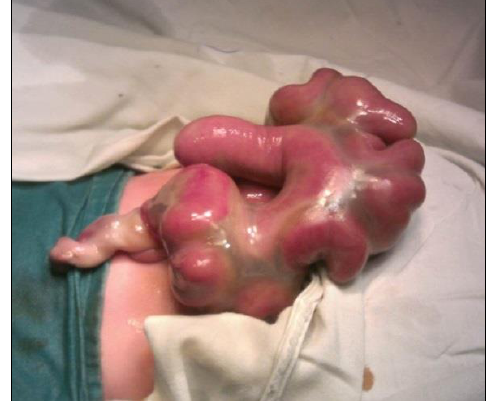
Figure 11: HUC with evisceration of bowel from the umbilical cord mimicking as gastroschisis on initial inspection.[2]